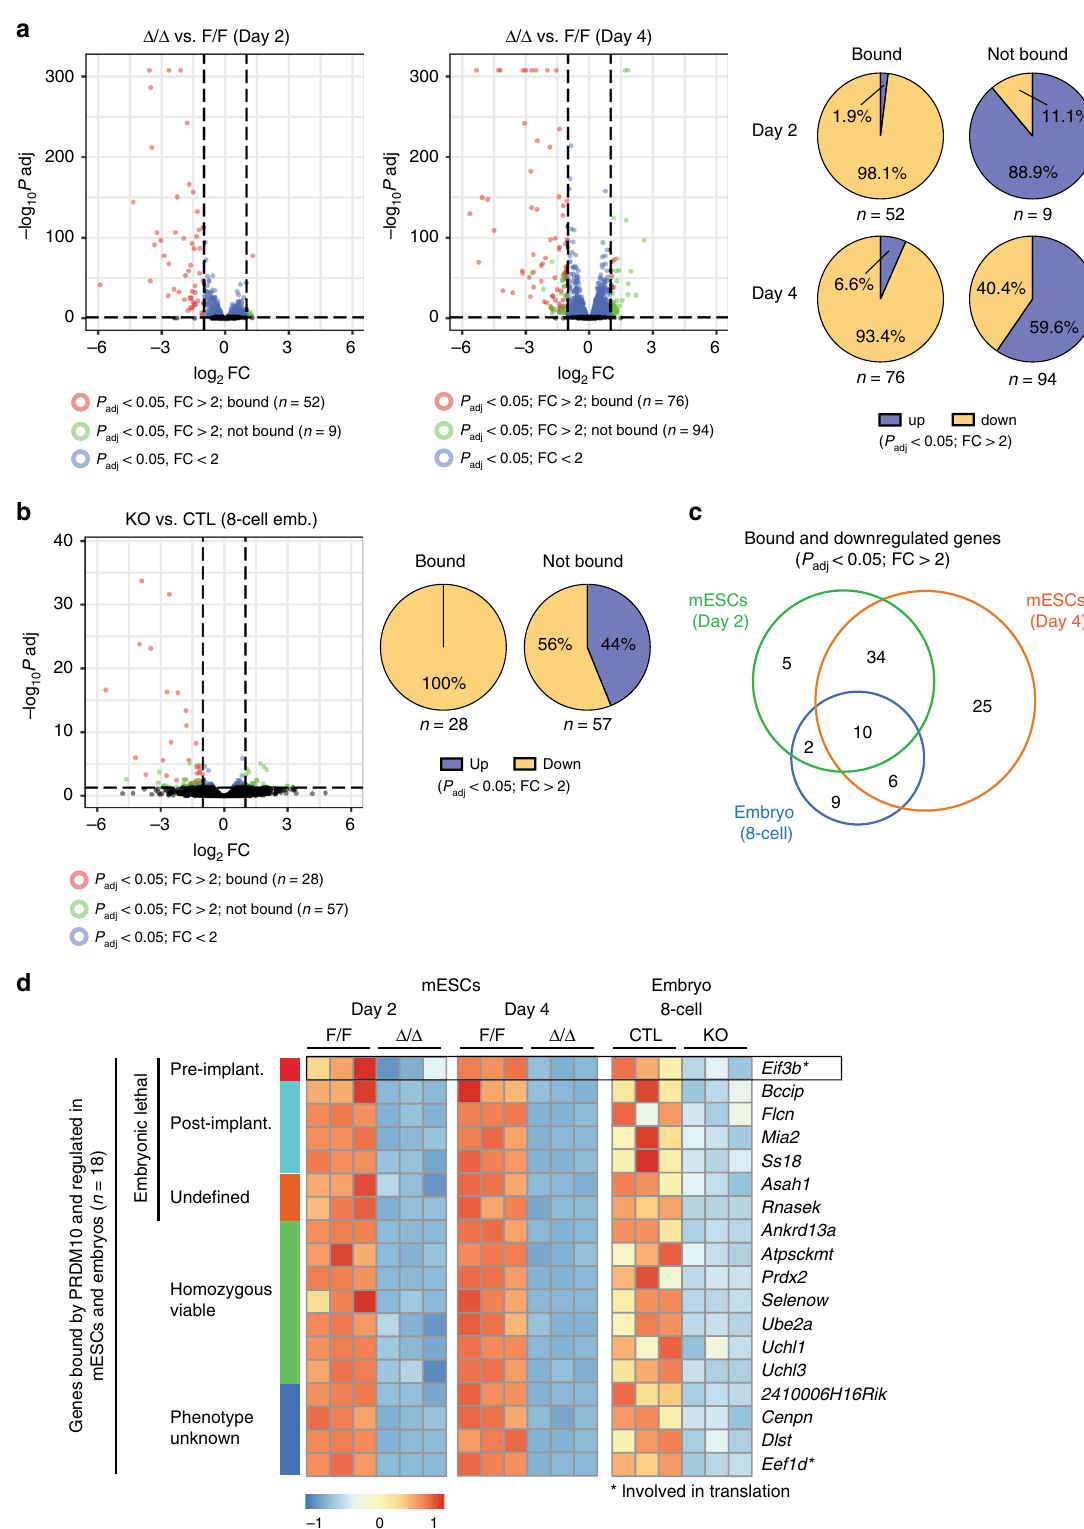
PRDM10 (Fig. 5e). Hence, PRDM10 is both necessary and suf- fi cient to maintain normal Eif3b expression levels in mESCs. EIF3B acts downstream of PRDM10 to promote translation